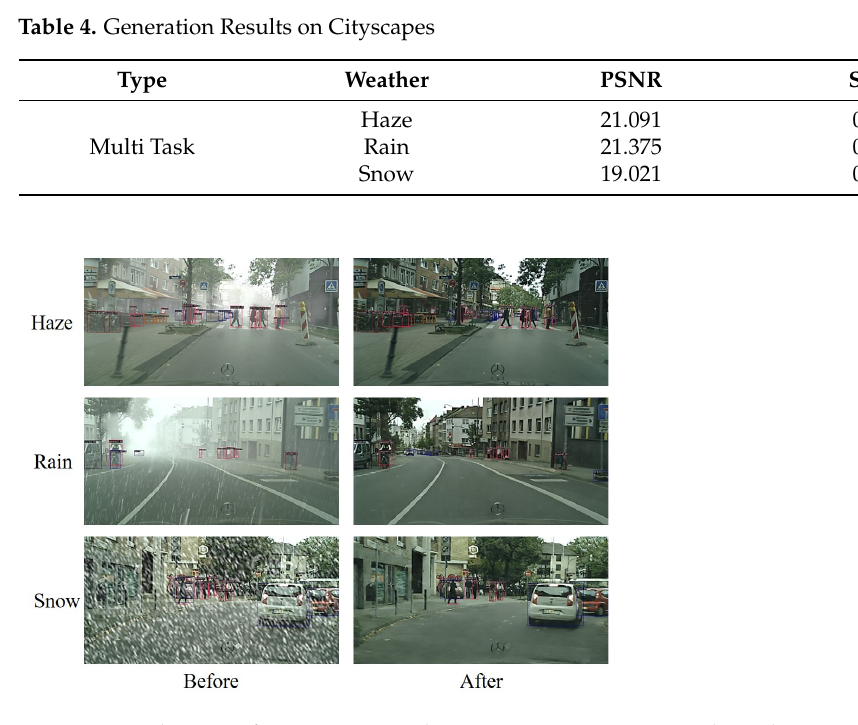
Figure 9. Application of MTWG on Weather Cityscapes using SOTA object